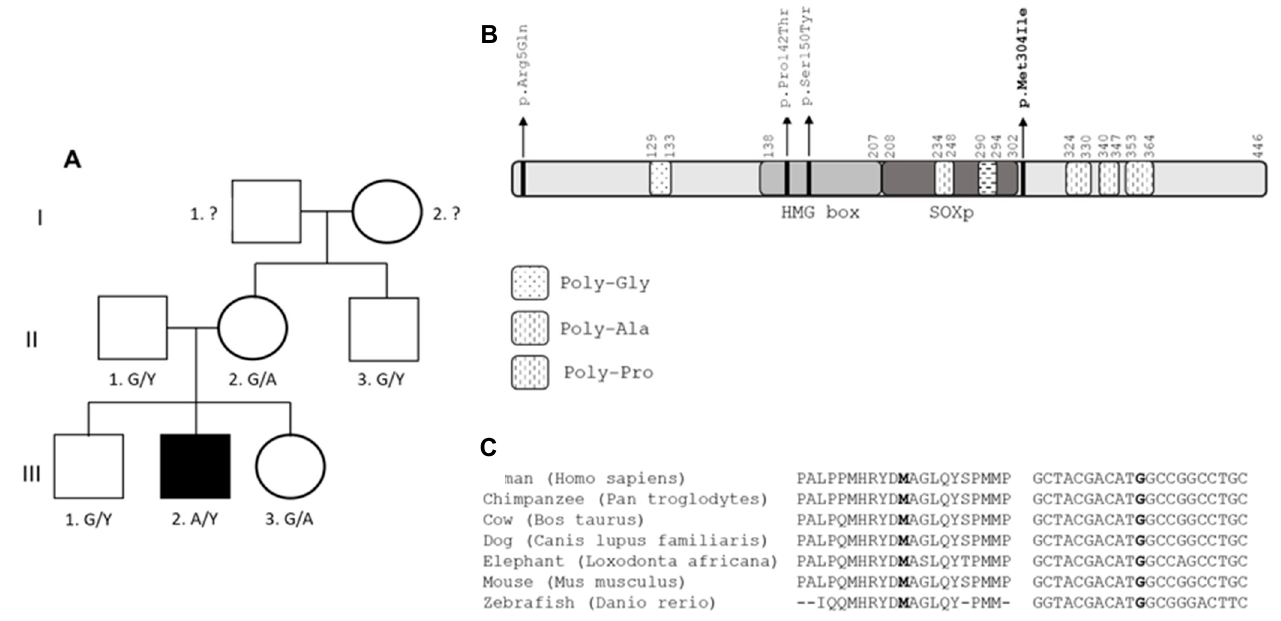
Figure 2. Segregation and conservation of SOX3 variant p.Met304Ile. ( A ) Family pedigree of the proband, III.2, illustrating the segregation of the G to A variant in SOX3 that results in p.Met304Ile. The male proband was the only affected individual, (III.2). Letters below each family member represent the genotype, considering G to be the normal allele and A the variant. ( B ) Protein diagram for SOX3. The missense variants mentioned in text are indicated. The high mobility group DNA binding domain (HMG) and SOXp domains are highlighted, as well as portion of the protein containing amino acid repeats. ( C ) SOX3 protein ( left ) and cDNA ( right ) are highly conserved across species at and around p.Met304. 3. The amino acid Met (M) and nucleotide (G) that are mutated in p.Met304Ile are in bold.